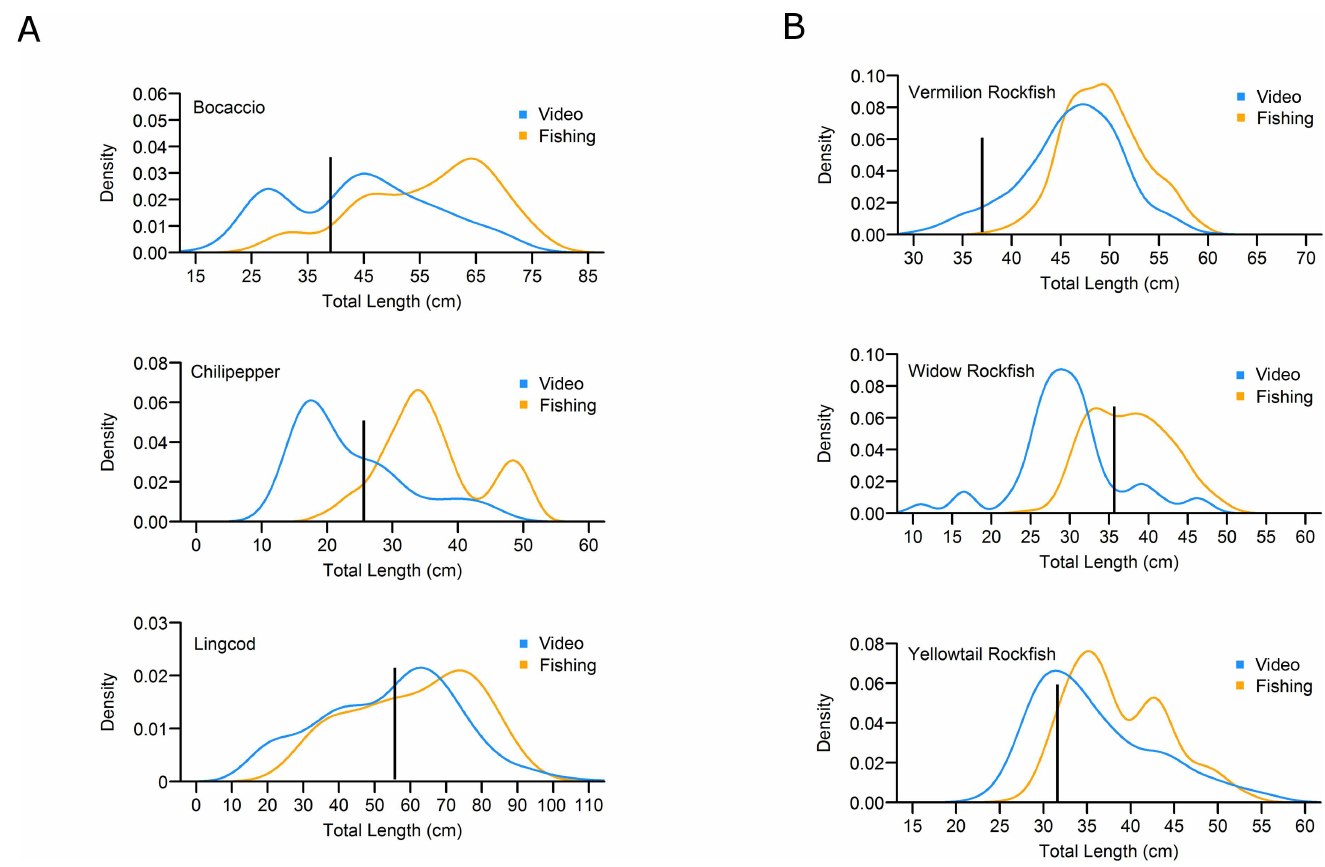
Fig 6. Length frequencies, expressedas kernel density distributions, of Bocaccio, Chilipepper, Lingcod, Widow Rockfish, Vermilion Rockfish, and Yellowtail Rockfish caught or observed in fishing or video surveys. The solid black line represents length at 50% maturity for